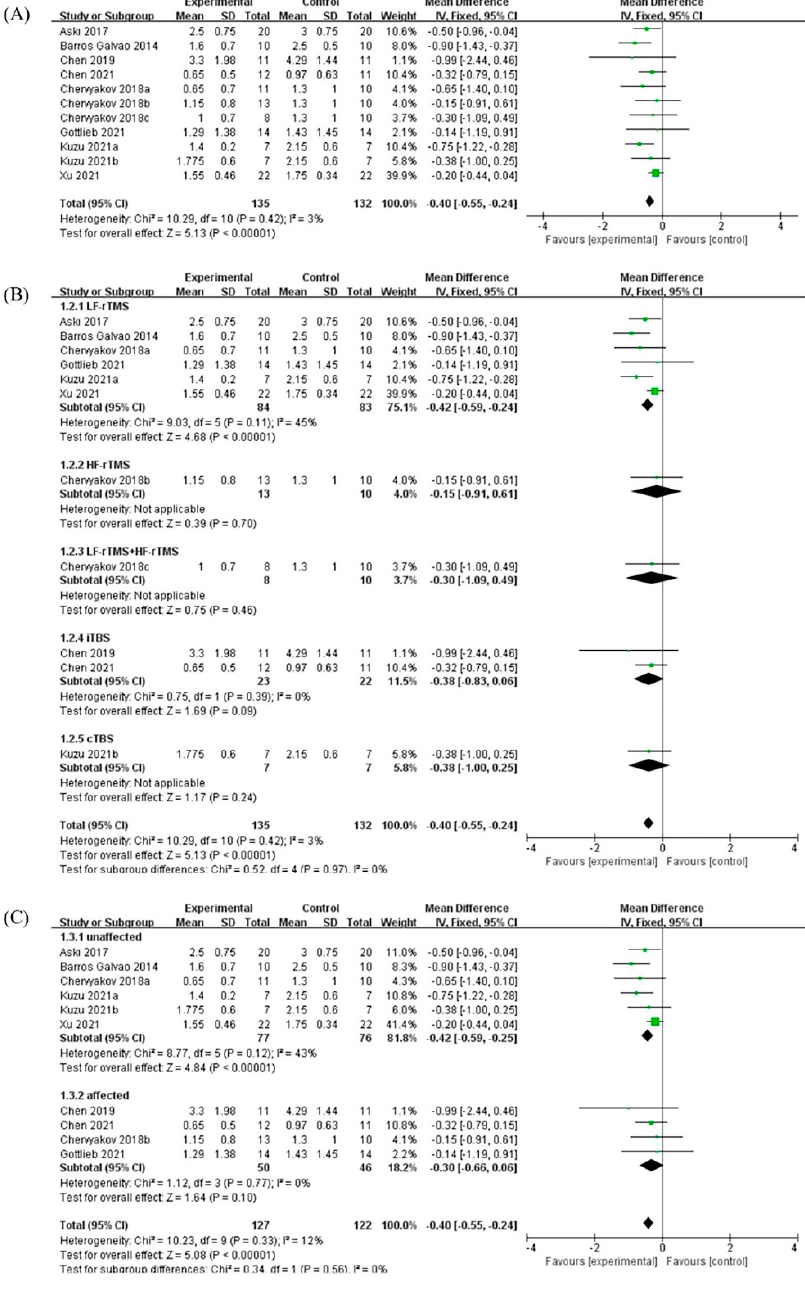
Figure 2. ( A ) Forest plot analysis of the effect of rTMS on post-stroke spasticity. ( B ) Forest plot analysis of the effects of different stimulation methods for rTMS on post-stroke spasticity. ( C ) Forest plot analysis of the effects of different stimulation sites for TMS on post-stroke spasticity.